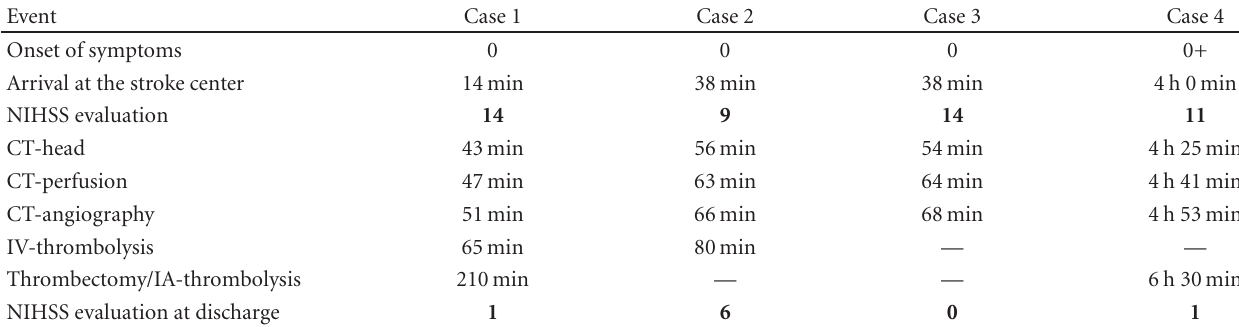
Table 1: Overview of starting times of relevant events and NIHSS scores for the four di ff erent